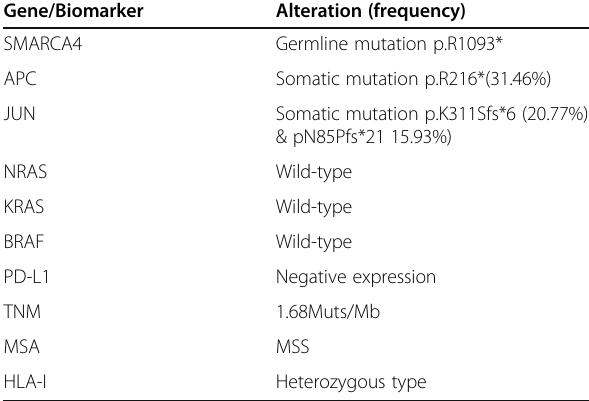
Table 1 Next-generation sequencing